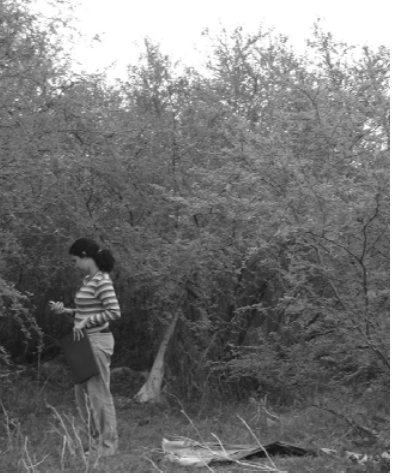
Figure 6 . Marabú size in densely concentrated regions .